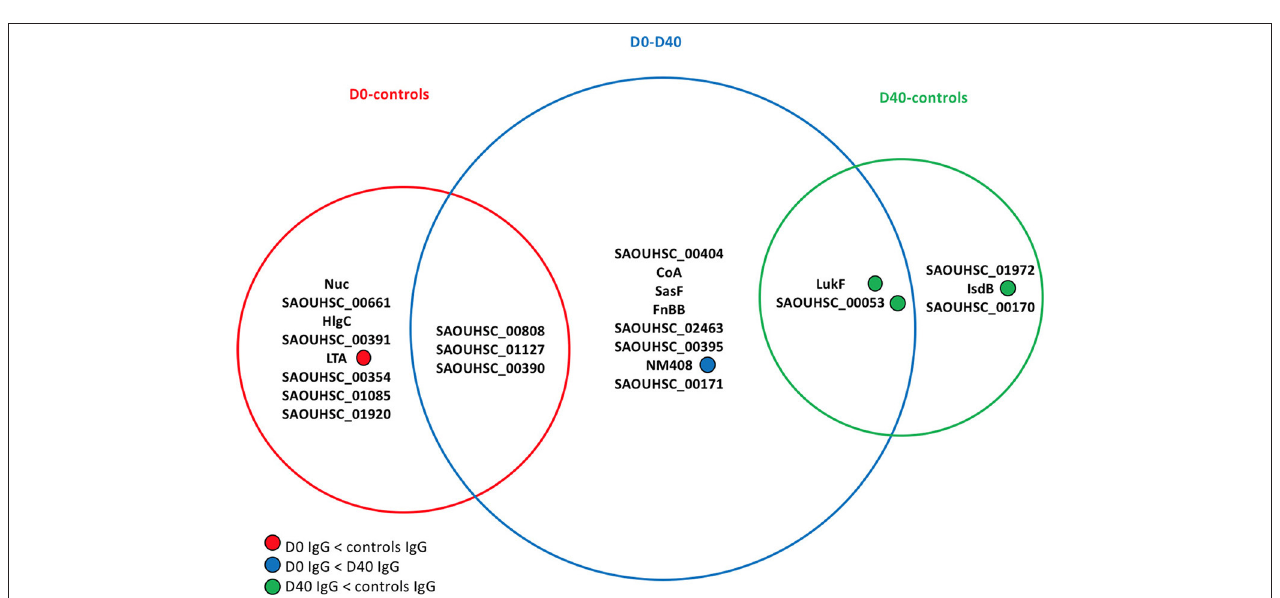
Frontiers in Immunology |